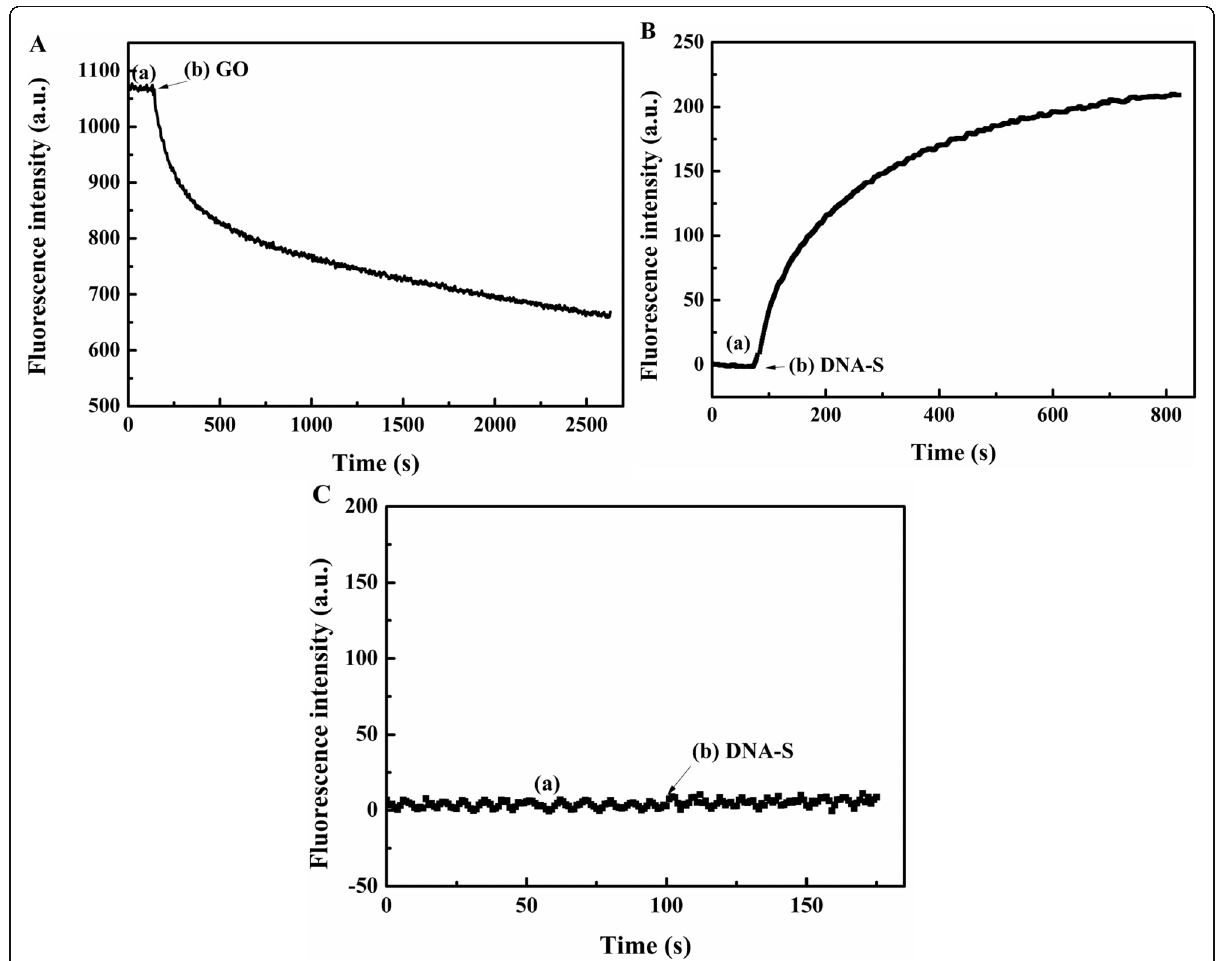
Fig. 2 Reaction time: A (a) PicoGreen dye, DNA-L, DNA-S, (b) GO. B (a) PicoGreen dye, GO, 100 μ L of 10 mM ATP, DNA-L, (b) DNA-S. C (a) PicoGreen dye, GO, DNA-L, (b)